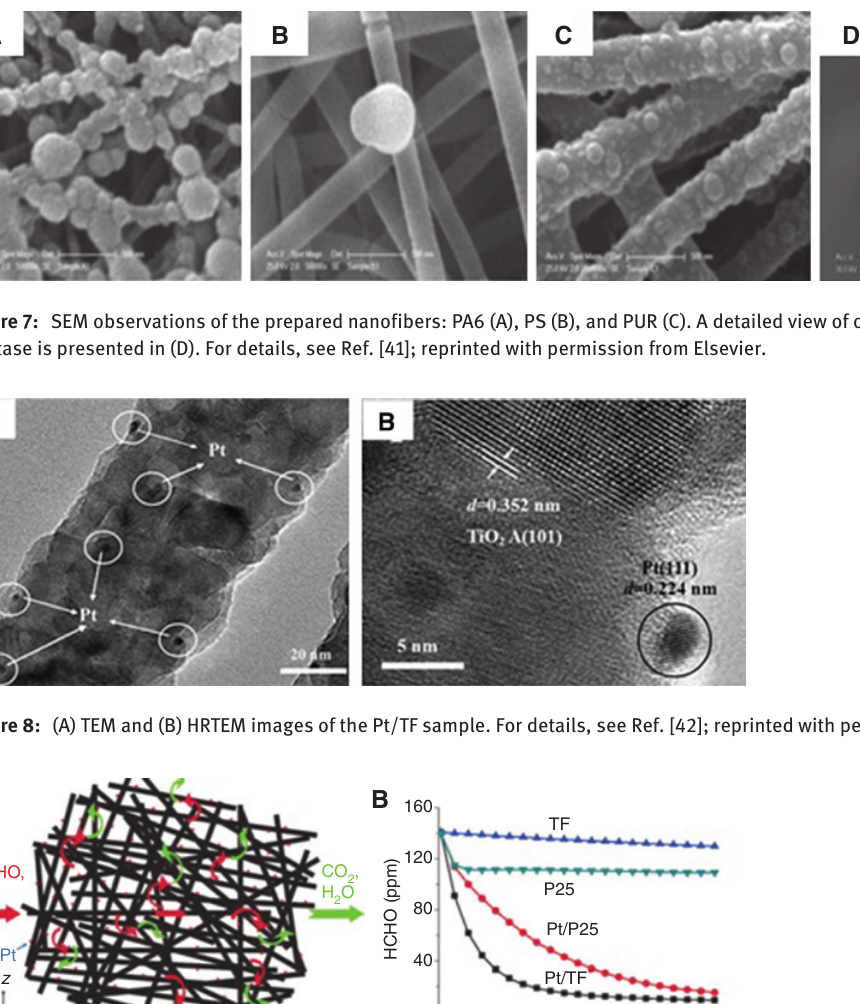
Figure 9: (A) Illustration of the fast diffusion of reactants (O the Pt/TF catalyst. (B) Changes in formaldehyde concentration as a function of reaction time for the Pt/P25 and Pt/TF samples. For details, see Ref. [42]; reprinted with permission from